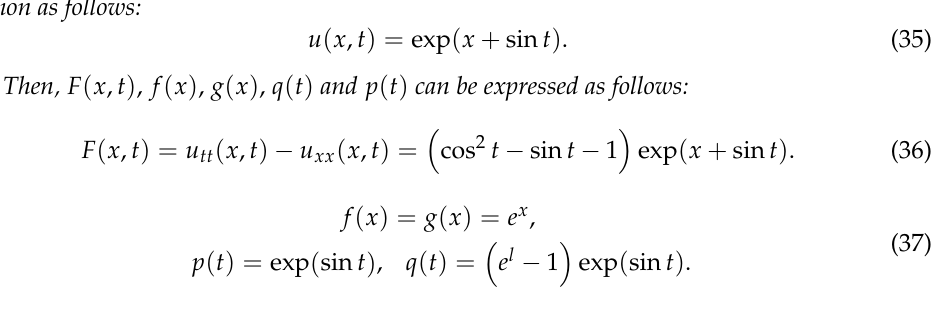
Figure 3. For Example 2: ME( u ) versus t in the time interval.